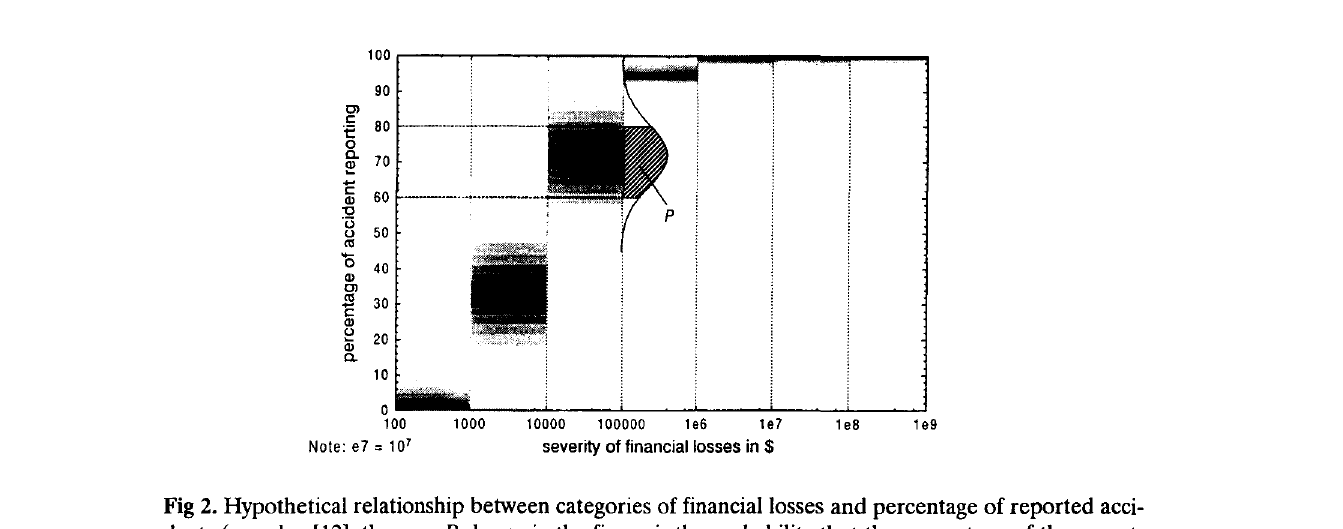
Fig 2. Hypothetical relationship between categories of financial losses and percentage of reported acci dents (see also [12]; the area P shown in the figure is the probability that the percentage of the report ing of the accidents causing losses between $10 and $100 thousands lies between 60% and 80